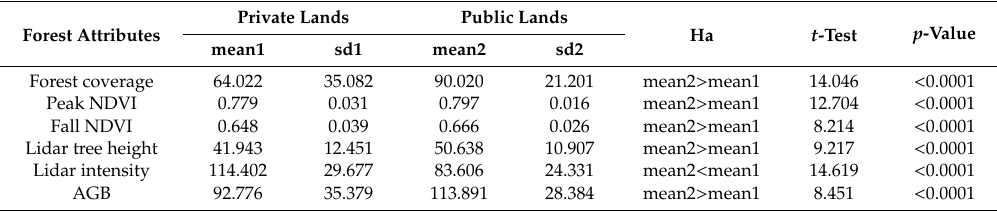
Table 2. Comparison of forest attributes between private and public lands by t -test (sd = standard deviation; Ha = alternative